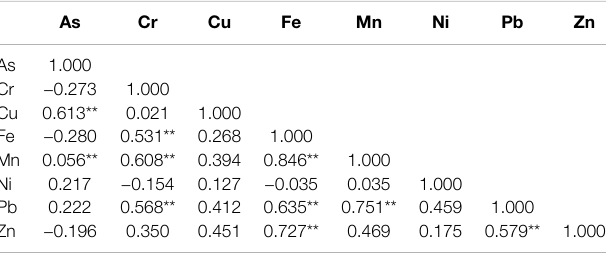
Frontiers in Environmental Science |